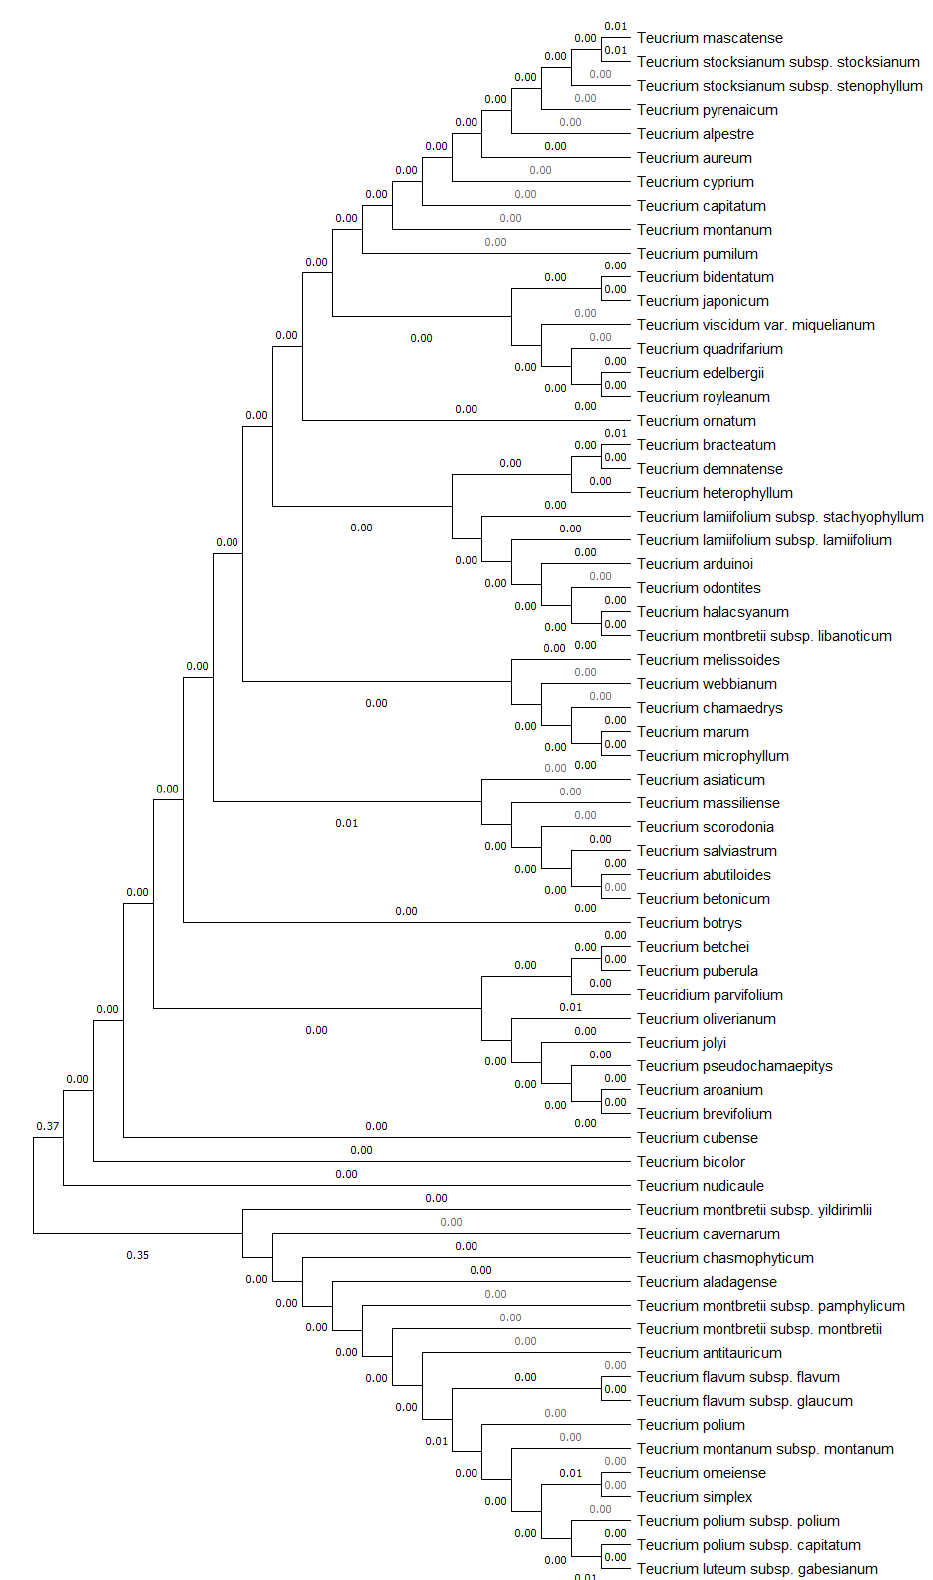
Figure 4. Phylogenetic tree of the genetic distances between Teucrium luteum subsp. gabesianum and 64 other Teucrium taxa (species and subspecies) retrieved from GenBank based on the trn L- trn F intergenic spacer sequences using the neighbor-joining